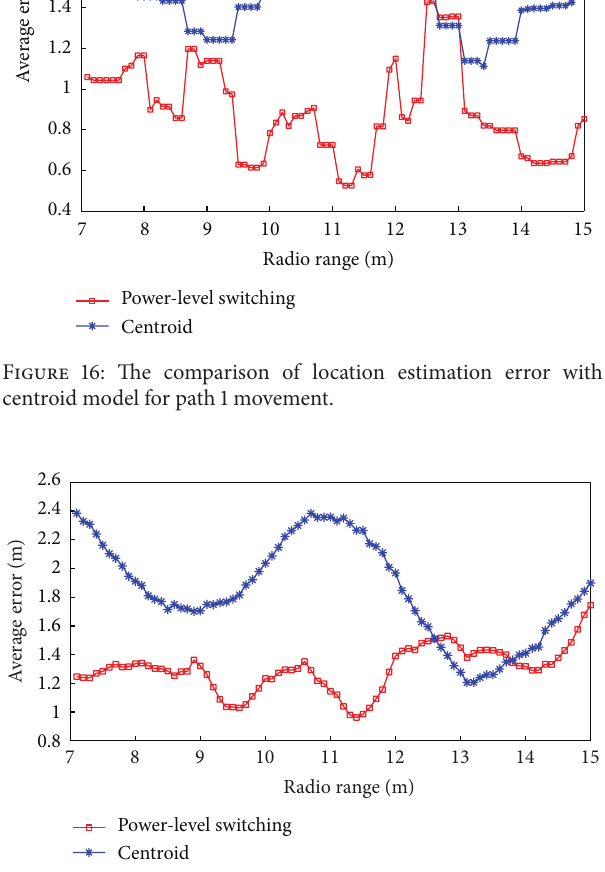
Figure 17: The comparison of location estimation error with centroid model for path 2